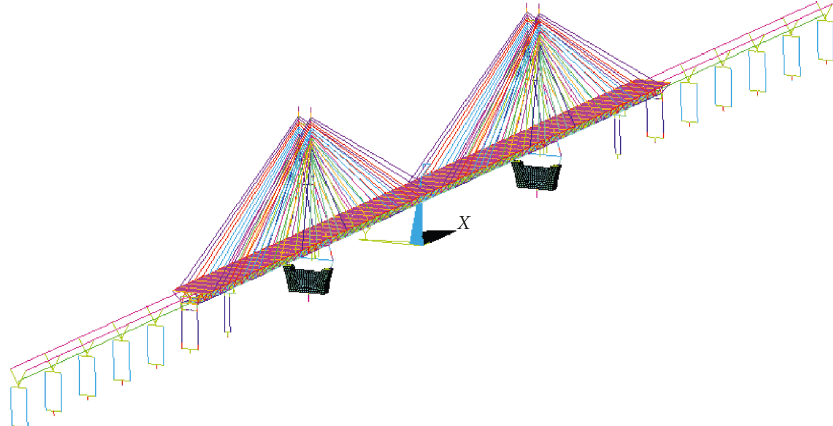
Figure 4: Finite element model of Niutianyang Bridge by software